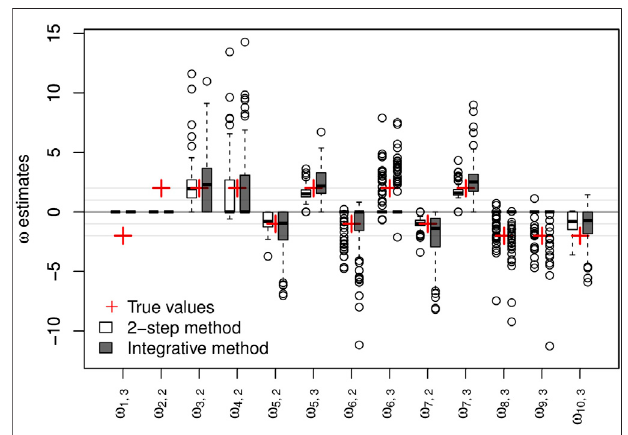
FIGURE 2| Results on arti fi cial data over 100 simulations. Non-negative { ω } parameter estimates and their respective true values. The y -axis represents the values of the estimates.